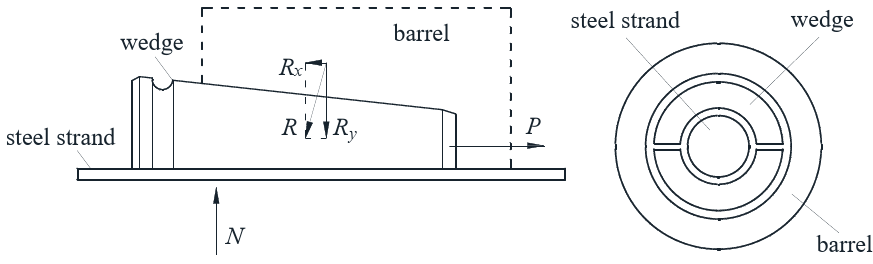
Figure 3. Schematic diagram of stress analysis.